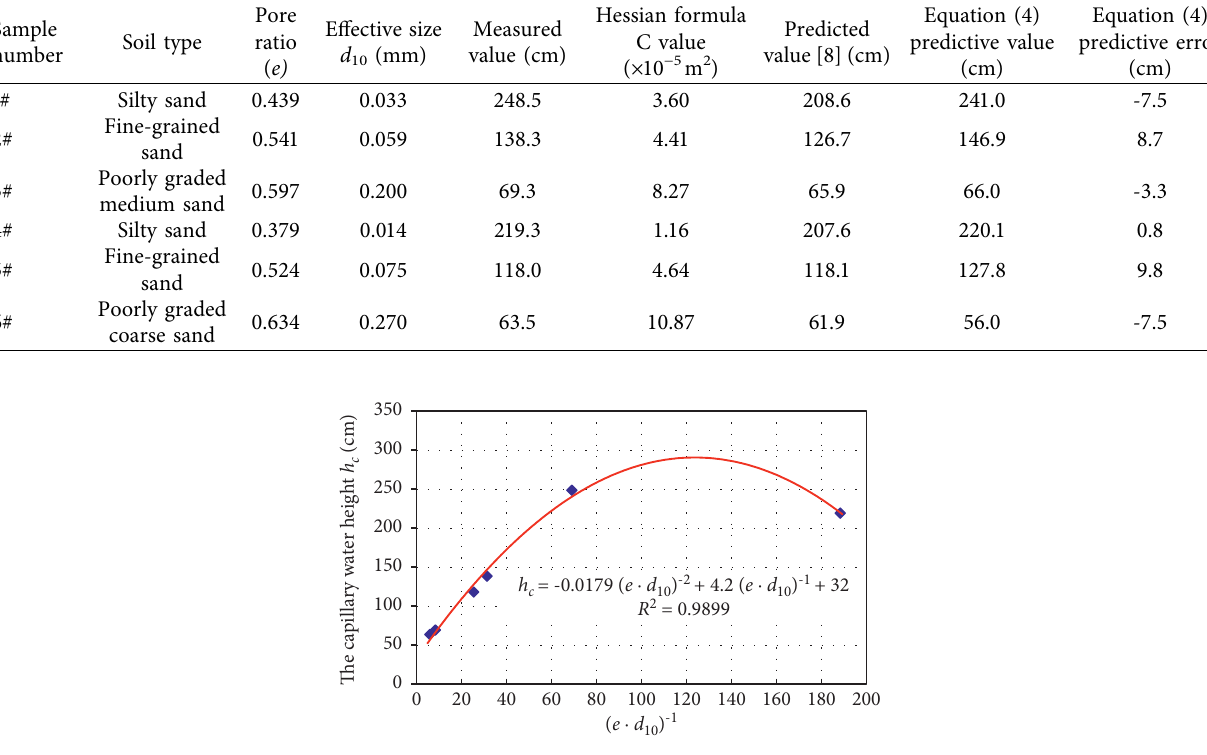
Figure 2: The stable height of the capillary water for the coarse-grained soil. Table 5: The comparison of the measured and predicted values of h c of the capillary water rise in the fine-grained soils. Sample